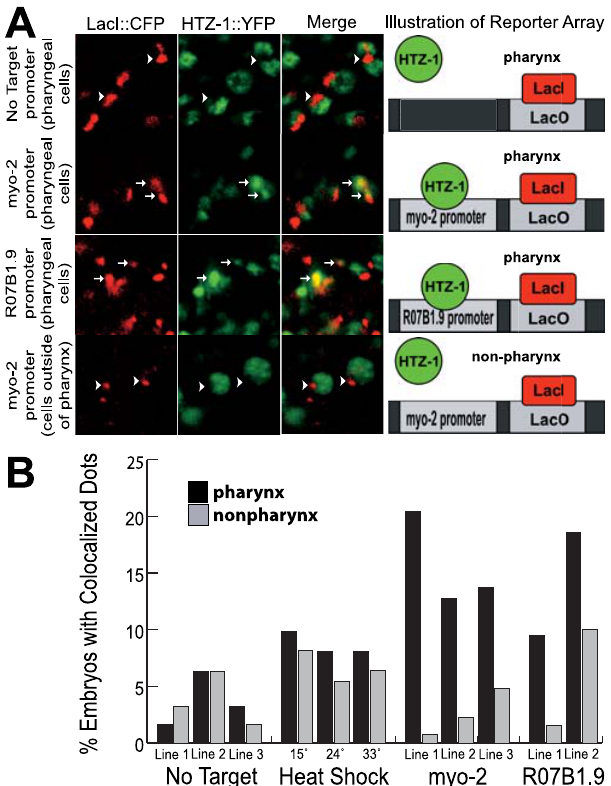
Figure 4. Association of YFP::HTZ-1 with Pharyngeal Promoters (A) Extrachromosomal target arrays were visualized by LacI::CFP (red) bound to the Lac operator (LacO). YFP::HTZ-1 (green) was excluded (arrowheads) from arrays with no-target promoter (row 1), but associated with target arrays containing promoters for pharyngeal genes myo-2 or R07B1.9 in pharyngeal cells ( rows 2 and 3). Merge is yellow. YFP::HTZ-1 was excluded from arrays containing the myo-2 promoter in non- pharyngeal cells (row 4). Cartoons depict interpretation of data. (B) Percentage of embryos containing one or more co-localized LacI::CFP and YFP::HTZ-1 dots in the pharynx (black) or outside of the pharynx (grey). Association was significantly higher in the three myo-2 promoter lines ( p , 0.0001) and two R07B1.9 lines ( p ¼ 0.0014). No significant difference in association was found when comparing the no-target lines to the heat-shock promoter target at 15 8 C, 24 8 C, or heat-shock at 33 8 C for 30 min ( p . 0.095). More than 60 embryos were scored for each no- target, heat-shock, and R07B1.9 line. More than 120 embryos were scored for each myo-2 line. YFP::HTZ-1 association was predominantly phar- yngeal for myo-2 ( p , 0.0001) and R07B1.9 ( p ¼ 0.0407) target arrays, but not control arrays ( p ¼ 1.00). An equivalent number of images were